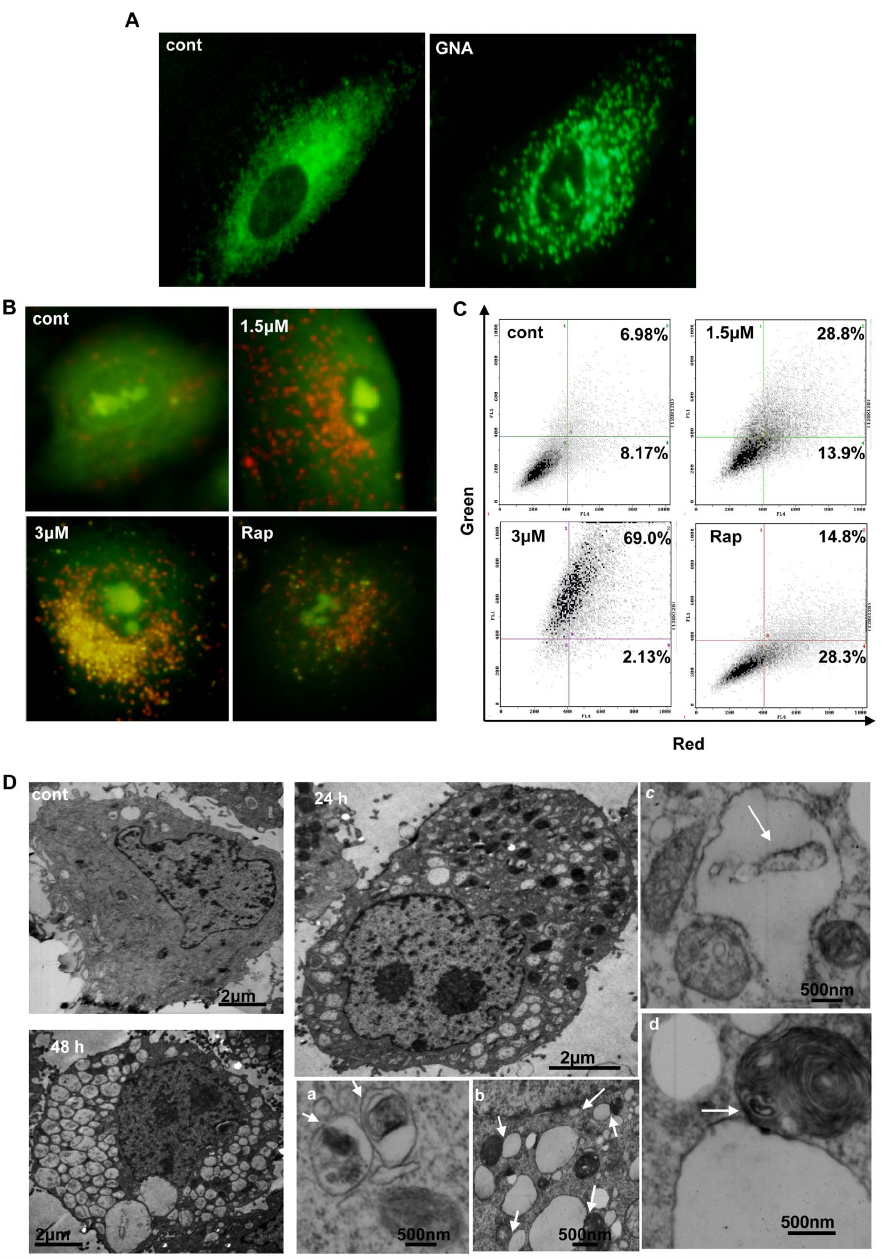
Figure 2. GNA increase autophagic markers in A549 and HeLa cells. A, Representative images of MDC staining. A549 cells were treated with 3 m M GNA for 24 hours, then stained with 10 m M monodansylcadaverine (MDC) and observed under a phase contrast microscope. B and C, Acridine orange staining. Cells were exposed to the indicated concentrations of GNA for 24 hours, then stained with 1 m g/ml of acridine orange (B, C) and observed under a phase contrast microscope (B) or analyzed by flow cytometry (C). Cells that were treated with 50 m g/ml of rapamycin were used as a positive control. The results shown are representative of at least 2 independent experiments. D, Representative electron microscopy images of GNA- treated A549 cells. The cells were treated with 3 m M GNA for the indicated periods of time and analyzed by electron microscopy. Arrows indicate the vacuoles contacting with vesicles that were densely filled with multi-lamellar structures.